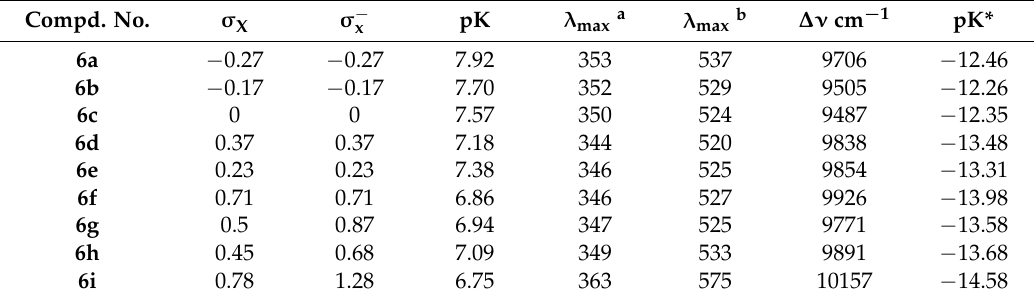
Table 2. Acid dissociation constants pK and pK* of 4-(5-arylazo-2-hydroxystyryl)-1-methylpyridinium iodide 6a – i . Compd. No.